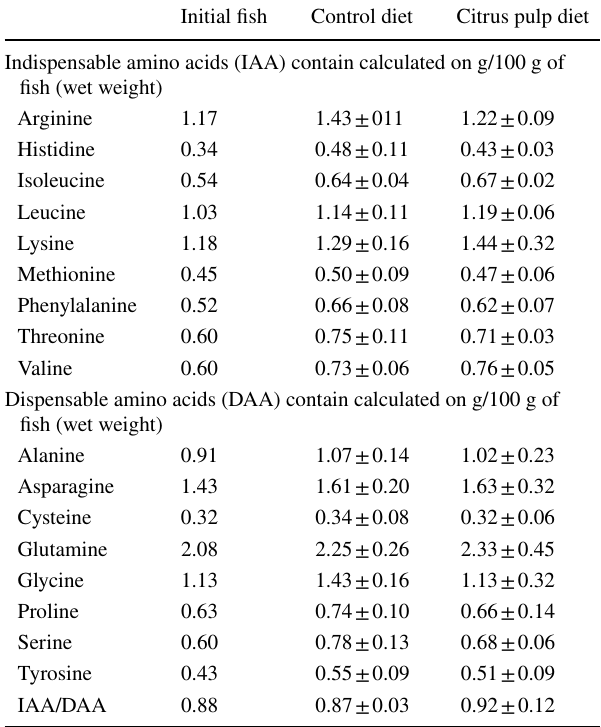
Values are ± SD of three